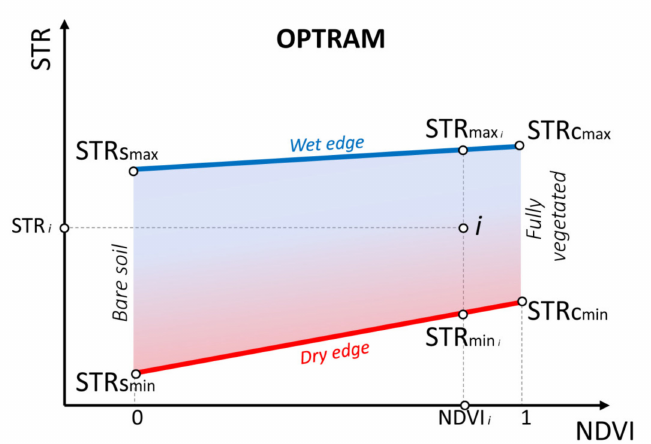
Figure 3. The concept of OPTRAM to retrieve a soil moisture index at the point i as a function of normalized di ff erence vegetation index (NDVI) and short-wave infrared transformed reflectance (STR). The wet edge is shown with a blue line and indicated by points STRs max and STRc max . The dry edge is shown with the red line and indicated by points STRs min and STRc min . The color gradient indicates the transition of moisture condition from the wet to dry edges. Point i with STR i and NDVI i represents moderate moisture availability. For i , the STR values of the wet and dry edges are STRmax i and STRmin i